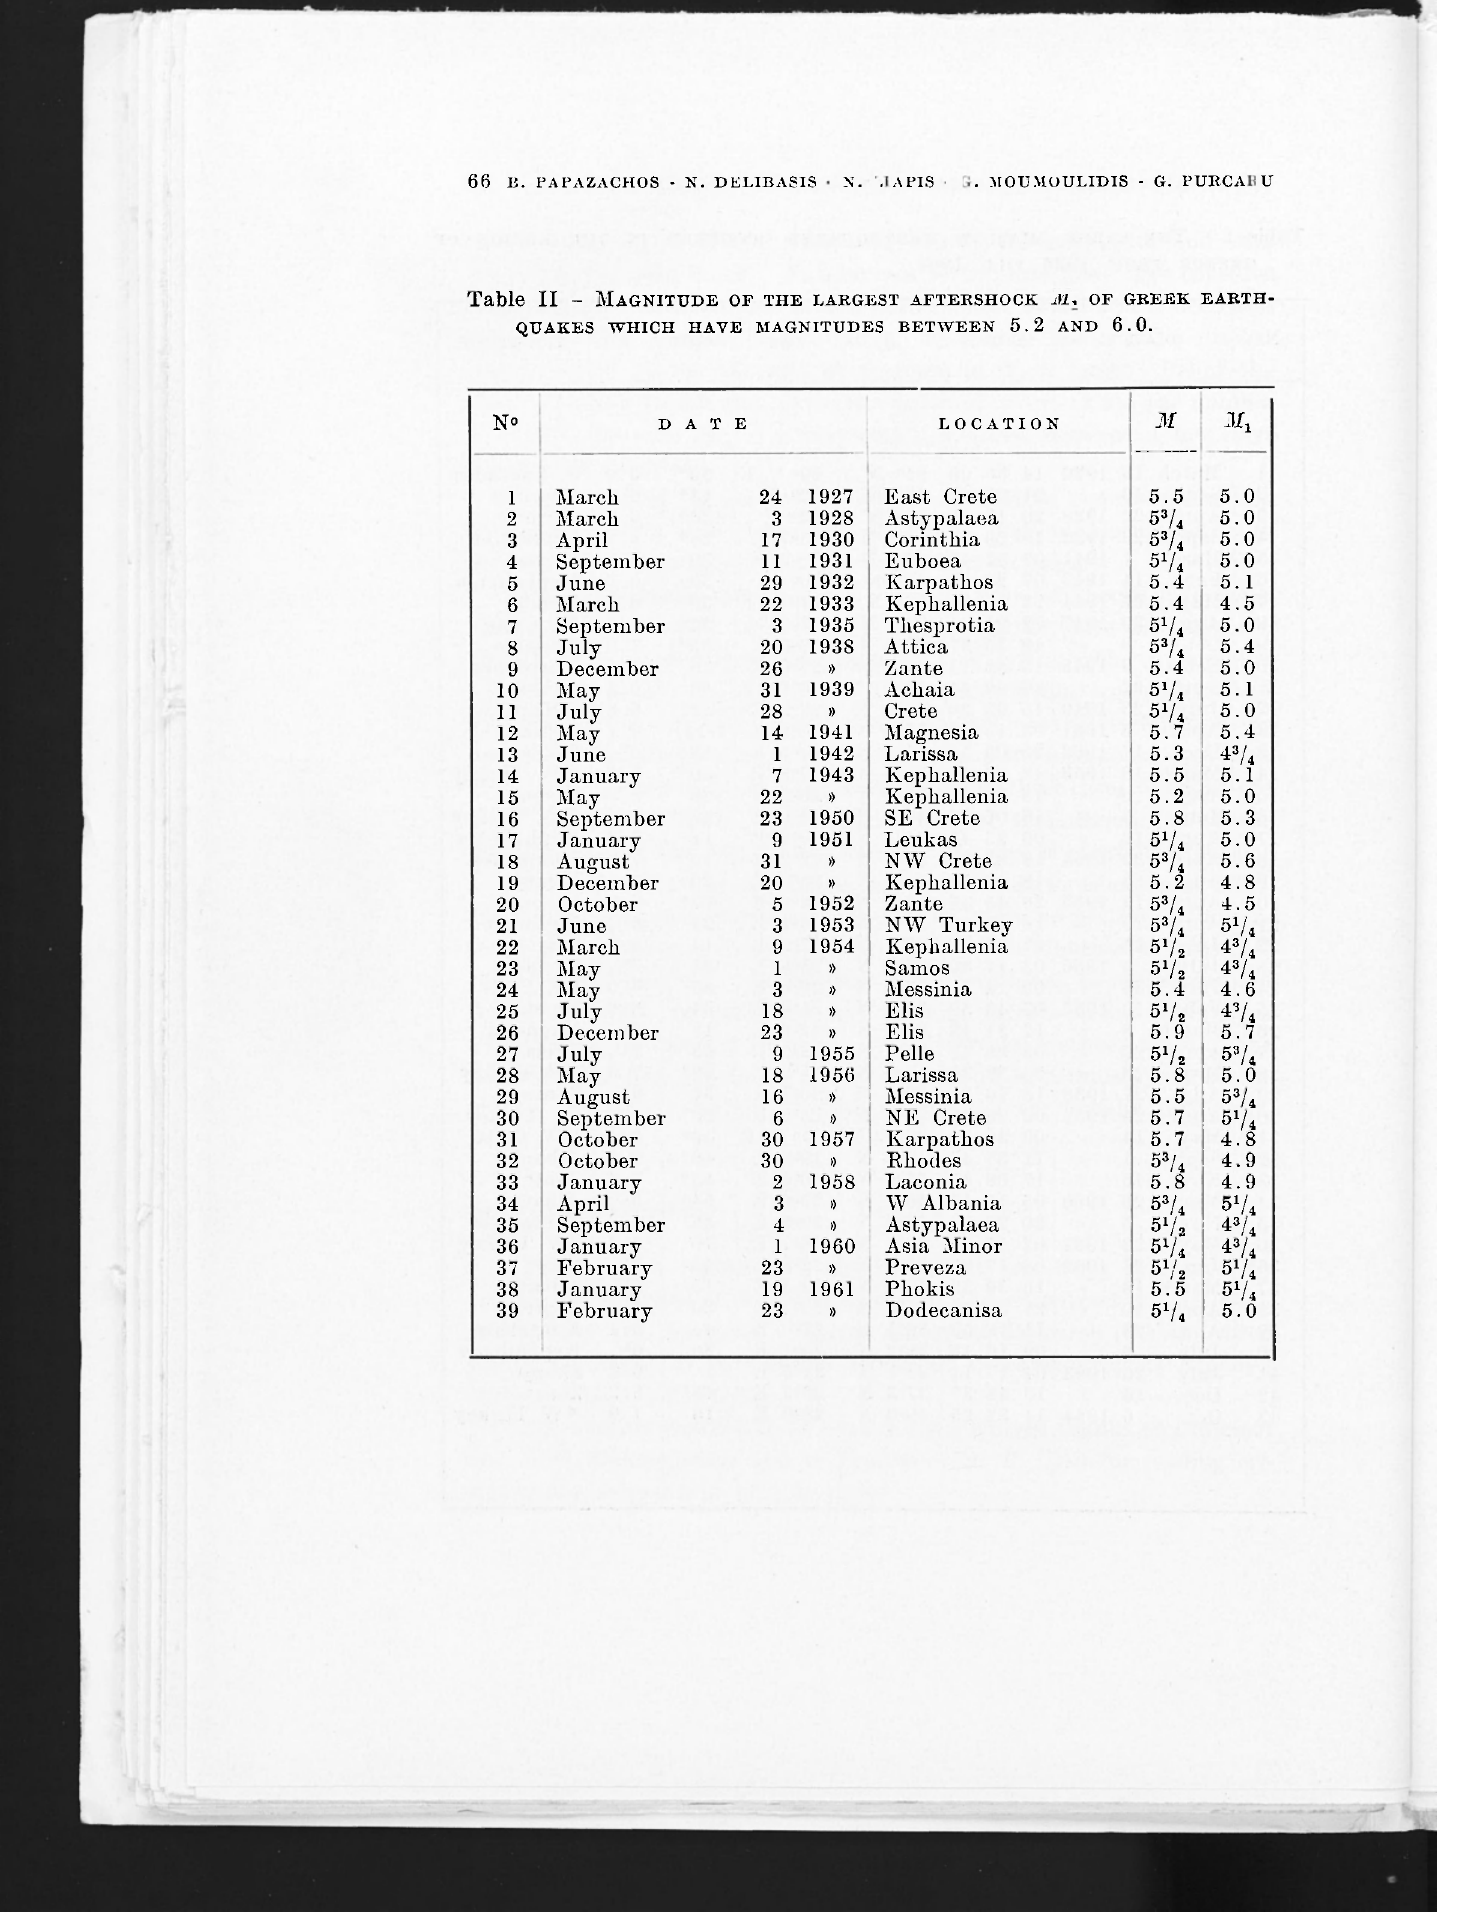
Table II - MAGNITUDE OF THE LARGEST AFTERSHOCK OF GREEK EARTH- QUAKES WHICH HAVE MAGNITUDES BETWEEN 5 . 2 AND 6 .